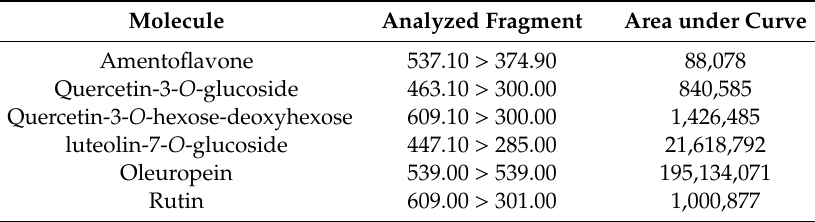
Figure 1. LC / MS-MS qualitative results of oleaster flavonoids. Figure 1. LC/MS-MS qualitative results of oleaster flavonoids. Table 1. Oleaster flavonoids displayed by LC / Table 1. Oleaster flavonoids displayed by LC/MS-MS.